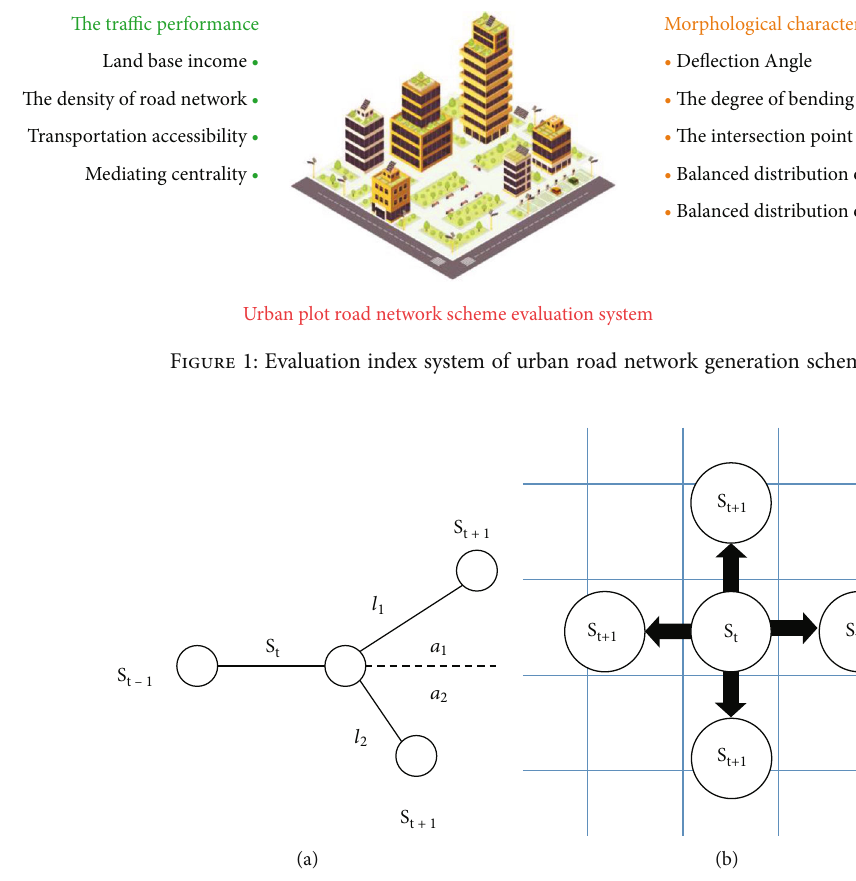
Figure 2: Comparison of two action space representations. (a) Motion space based on vector representation. (b) Action space based on grid